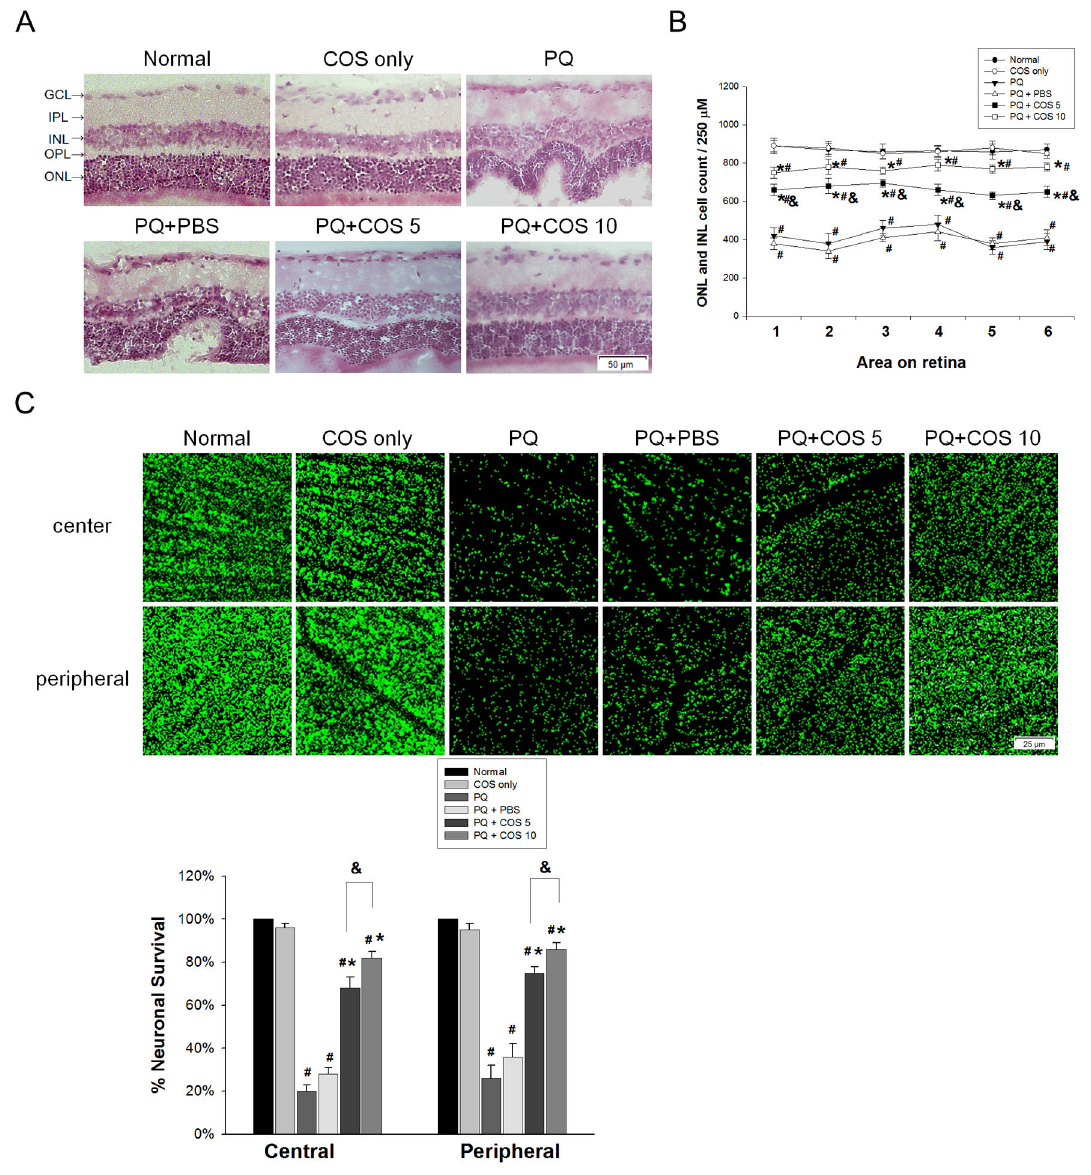
Figure 2. Effects of COS on retinal morphology, retinal cells and ganglion cell layer count. (A). PQ-injected rats showed diffuse thinning of inner and outer nuclear layer (INL, ONL) and folds in ONL, while low-dose or high-dose COS treatment showed better preservation of the INL and ONL at day 14. (B). low-dose and high-dose COS-treated group significantly preserved more cells in INL and ONL than PBS-treated and untreated group. (N=5 in each group). (C). Representative confocal images of Neu N-labeled neurons (green) in the regions of center and peripheral flat-mounted retinas of four groups. Neu N is the neuron marker for the quantification of surviving neurons in the ganglion cell layer (GCL). The percentage of surviving neurons in the GCL was significantly higher in COS-treated group than PBS-treated and untreated groups both in the center and peripheral regions of retinas at day 14. (N=3 in each group). (* P < 0.05 compared with PQ only or PBS-treated group; # P < 0.05 compared with normal; & P < 0.05 by ANOVA test with post hoc Bonferroni test). doi: 10.1371/journal.pone.0077323.g002 Bonferroni test; N=3 in each group). The low-dose and high- PBS-treated group at day 7 ( P <0.01, low-dose vs. PQ only or dose COS treatment groups significantly reversed the increase PBS-treated group; P <0.01, high-dose vs. PQ only or PBS- in the Bax/Bcl-2 ratio, when compared with the PQ only or treated group; two-way ANOVA with post hoc Bonferroni test ;